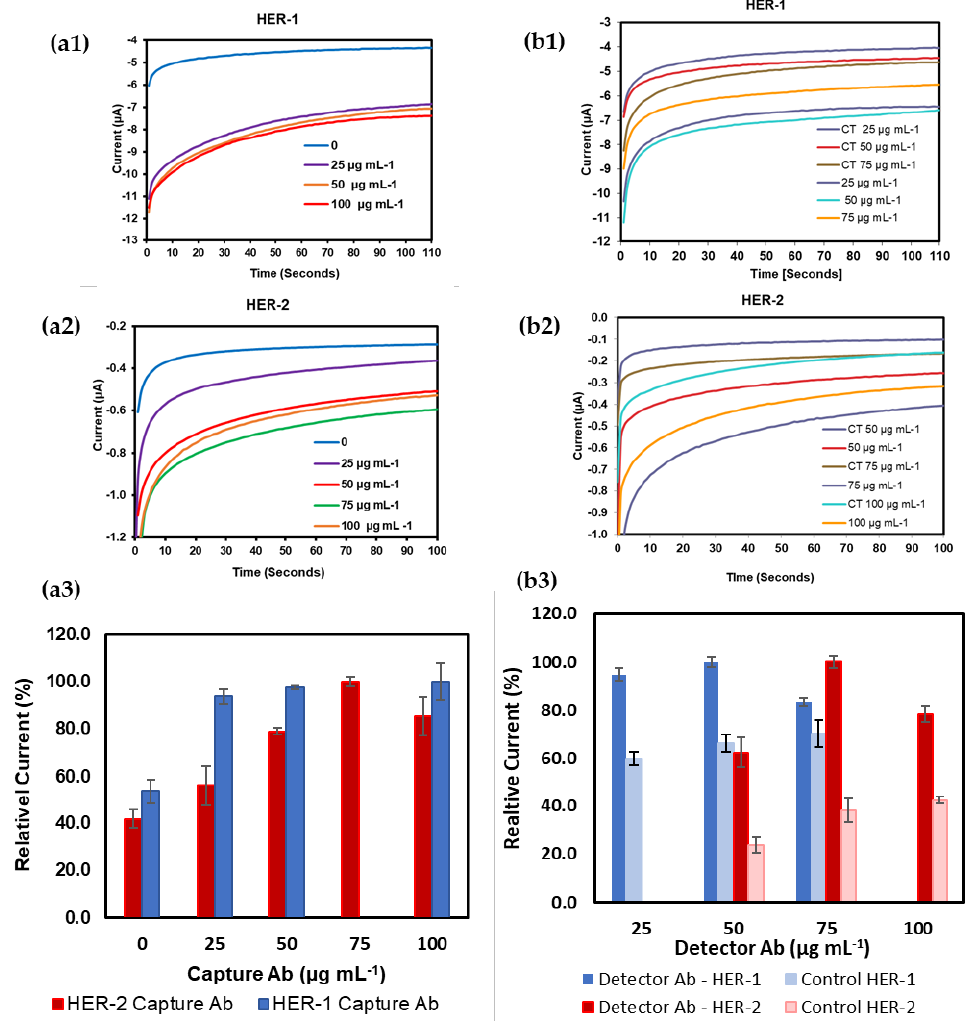
Figure 1. Chronoamperometric signal for SPGE; ( a1 ) different concentrations of monoclonal anti- HER-1; ( a2 ) anti-HER-2 as the capture antibody; ( a3 ) the relative current percentage calculated for each concentration for both HER-1 and HER-2; ( b1 ) different concentrations of polyclonal anti-HER-1; ( b2 ) anti-HER-2 as the detector antibody; ( b3 ) the relative current percentage calculated for each concentration for both HER-1 and HER-2. Standard deviations were calculated for experiments performed in triplicate. In ( b1 , b2 ) CT stands for control readings.